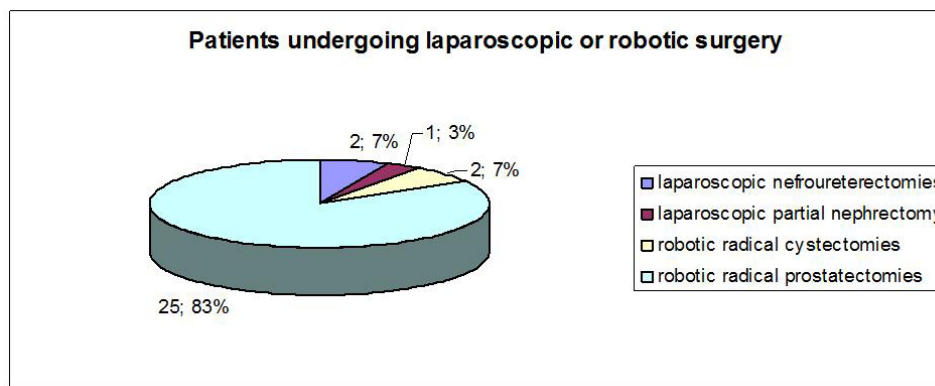
Figure 1: Patients undergoing laparoscopic and robotic surgery